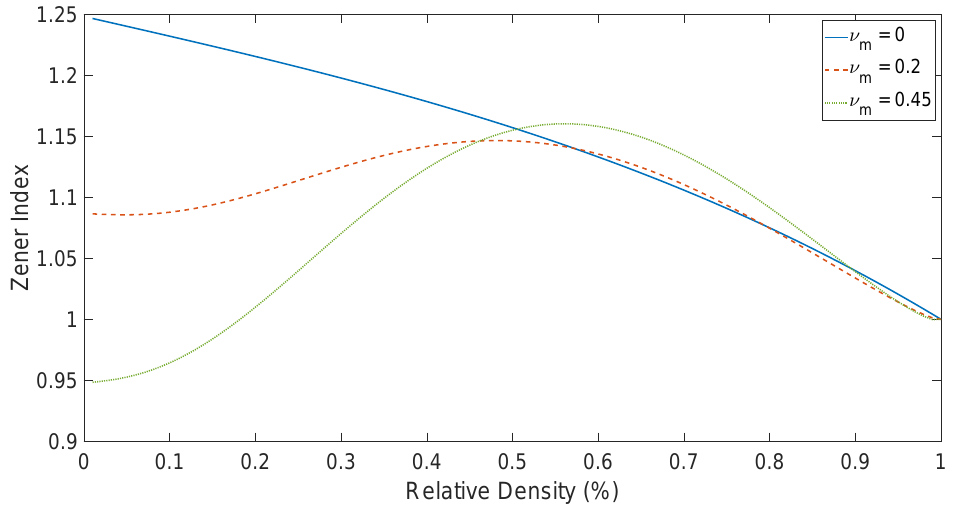
Figure 16. Zener index of gyroid